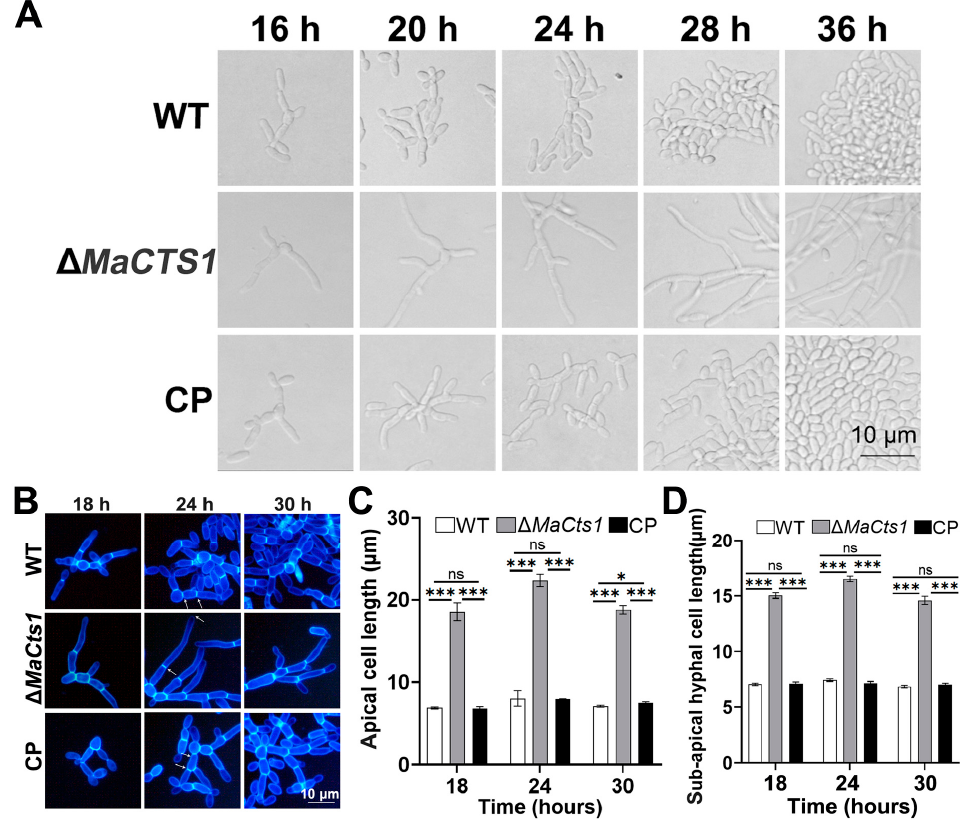
Figure 4. The conidiation pattern and hyphal morphology. ( A ) The conidiation pattern of the WT, Δ MaCts1 and CP strains on SYA medium. ( B ) The hyphae from the WT, Δ MaCts1 and CP strains grown on SYA medium for 18, 24, 30 h. The hyphae were stained with calcofluor white. Arrows indicate mycelial septa. ( C ) The length of apical hyphal cells in the WT, Δ MaCts1 and CP strains. ( D ) The length of sub ‐ apical hyphal cells in the WT, Δ MaCts1 and CP strains. Error bars indicate standard deviations from triplicate experiments. Three asterisks indicate significant differences at p < 0.001, one asterisks indicate significant differences at p < 0.05 and “ns” indicates no difference.